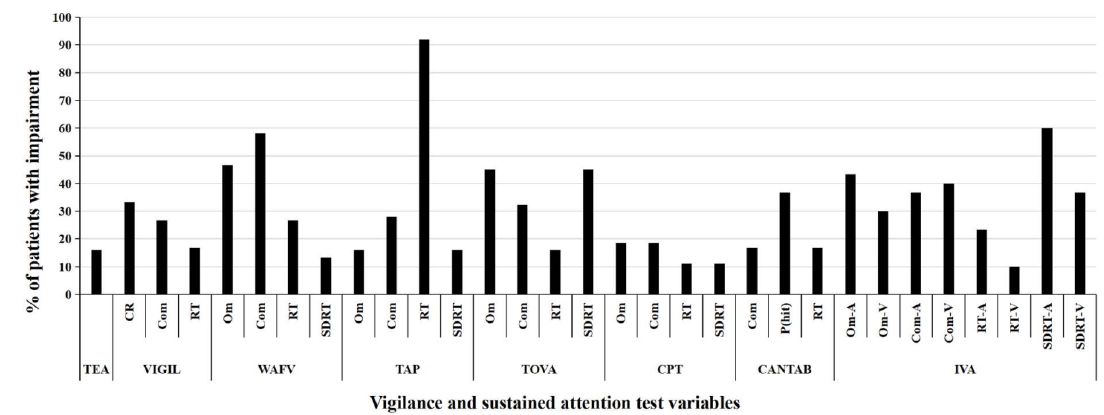
Figure 2. Percentage of patients showing impairment in each test variable. Note: A test variable is de- fined as impaired if T -score ≤ 40. TEA = Test of Everyday Attention. VIGIL = VIGIL of the Vienna Test System (VTS). WAFV = Perception and Attention Functions—Vigilance of the VTS. TAP = Test Battery for Attention Performance. TOVA = Test Of Variables of Attention. CPT = Conners’ Continuous Per- formance Test. CANTAB = Cambridge Neuropsychological Test Automated Battery—Rapid Visual Processing. IVA-2 = Integrated Visual and Auditory Continuous Performance Test. CR = Correct responses. Com = Commissions. RT = Reaction time. Om = Omissions. SDRT = Standard deviation of reaction times. P(hit) = Probability of a hit. Omi-A = Omissions, Auditory. Omi-V = Omissions, Visual. Com-A = Commissions, Auditory. Com-V = Commissions, Visual. RT-A = Reaction time, Auditory. RT-V = Reaction time, Visual. SDRT-A = Standard deviation of reaction times, Auditory. SDRT-V = Standard deviation of reaction times, Visual. Table 3. Proportion of patients with ADHD showing impairments in no, one, or more than one test regarding the corresponding test